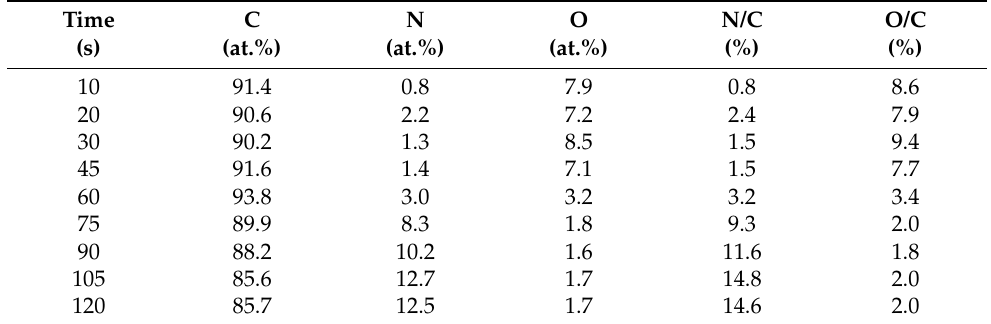
Table 1. Surface composition of as-deposited N-doped carbon nanomesh versus deposition